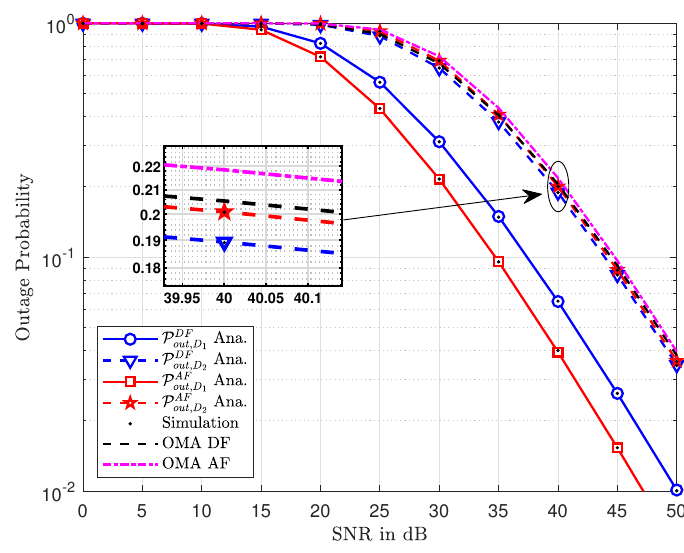
Figure 2. The outage probability versus transmit SNR. Figure 3 indicates the impact of power allocation coefficients Ξ 1 on the outage performance.